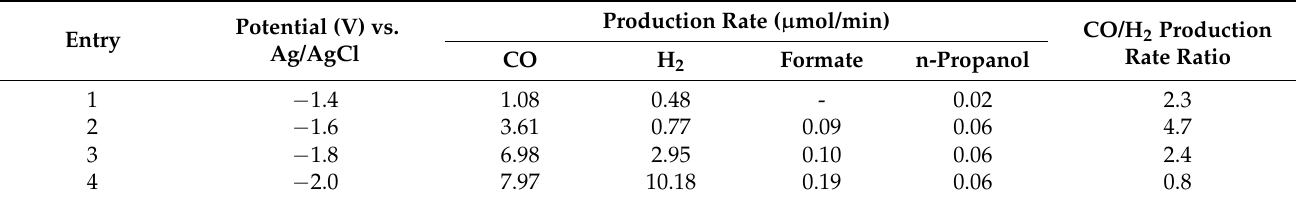
Figure 6. LSV results of the Zn/Cu–Na200 catalyst. Table 4. Performance of Zn/Cu–Na200 in CO 2 RR at various potentials for 70 min.